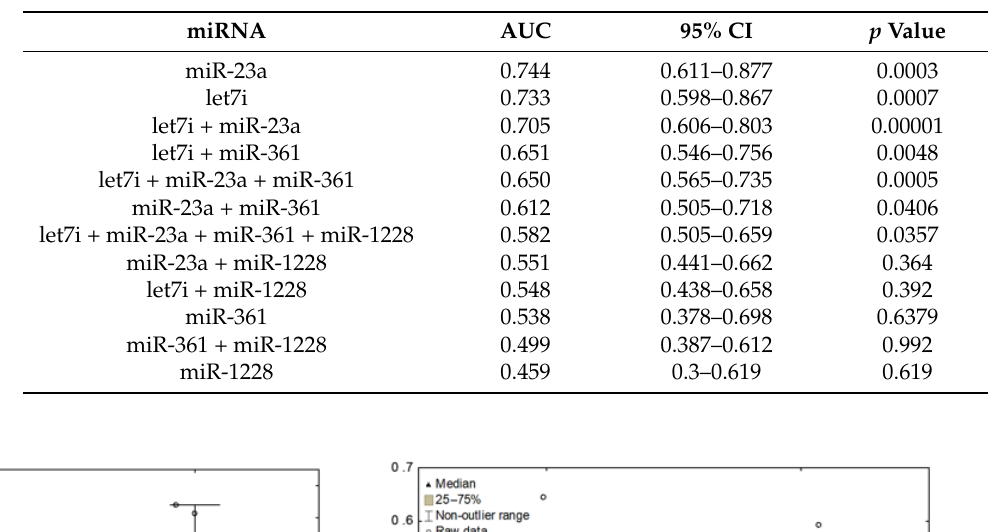
Table 3. Diagnostic values with area under the curve (AUC) data from ROC curves and 95% confidence intervals (CI) for serum EV-derived miRNAs (individually and in panels).